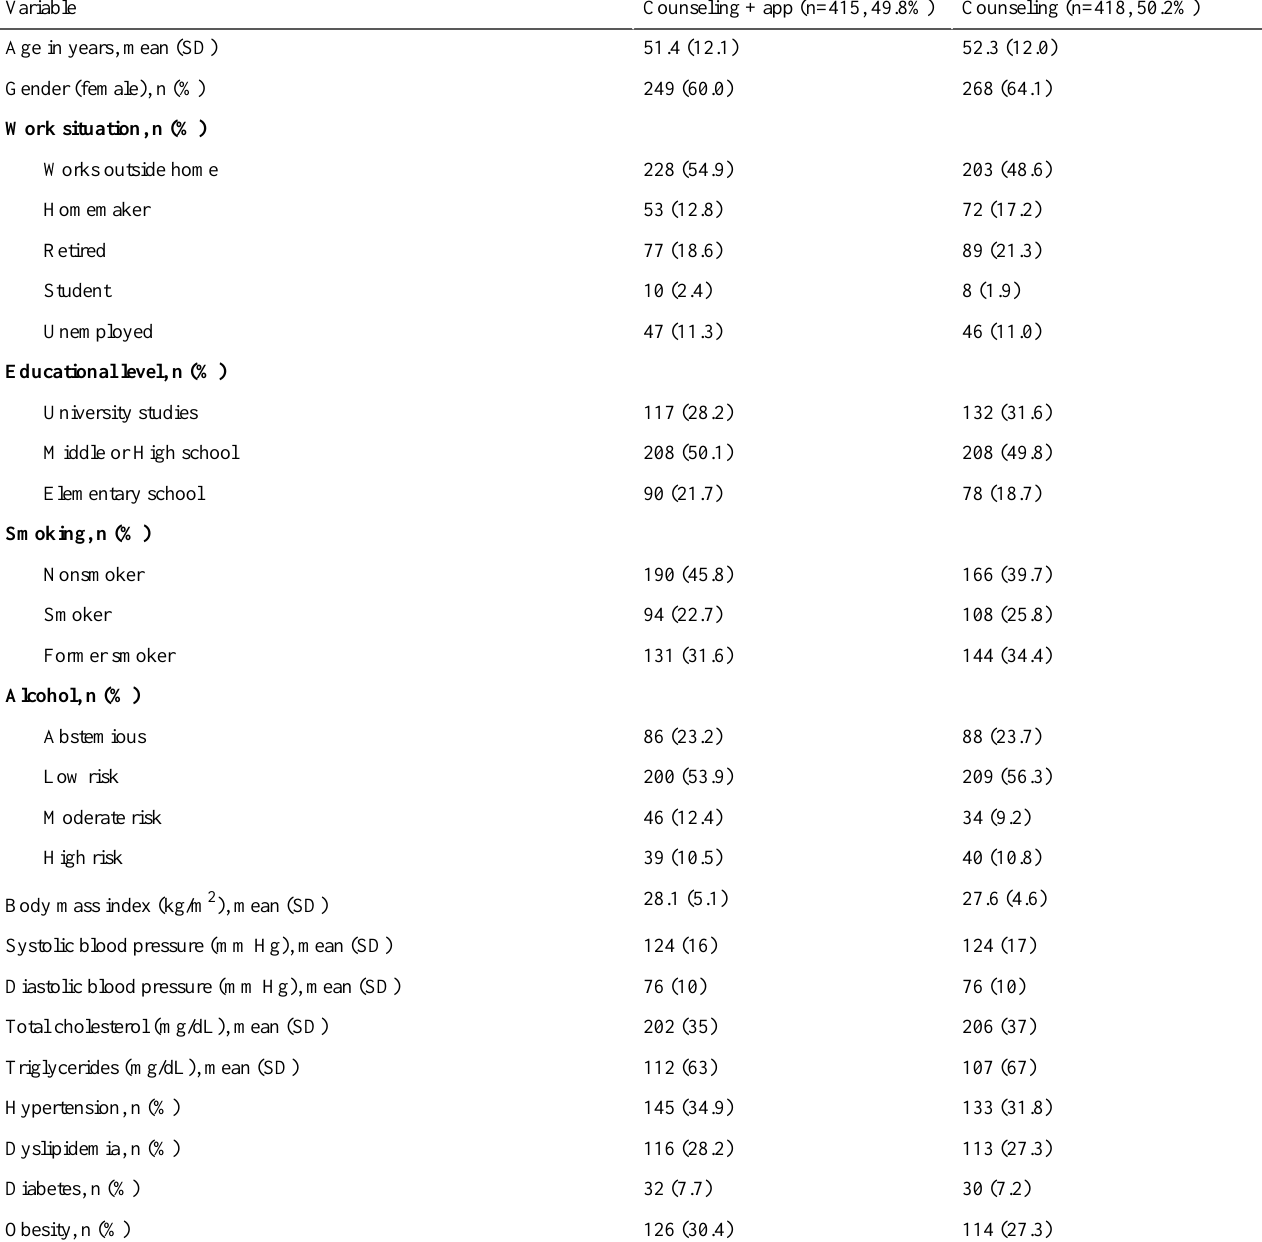
Table 1. Baseline characteristics of the study population (N=833). Categorical variables are expressed as n (%) and continuous variables as mean